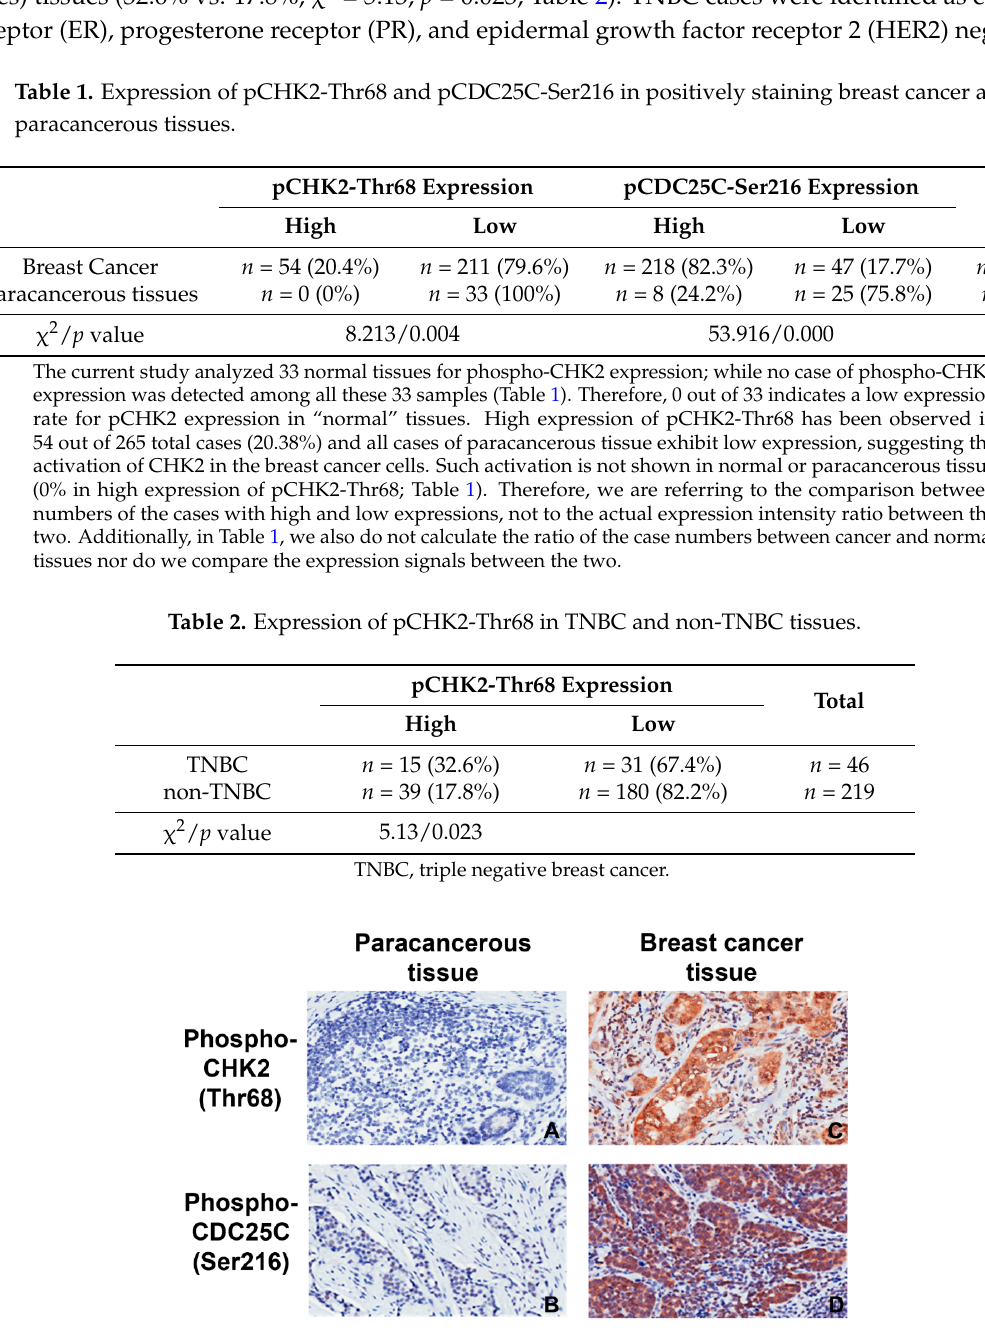
Figure 1. Representative pictures of the immunohistochemical staining of: pCHK2-Thr68 ( A ); and pCDC25C-Ser216 ( B ) in paracancerous tissues. pCHK2-Thr68 ( C ); and pCDC25C-Ser216 ( D ) staining in breast cancer tissues. Original magnification, ×200.